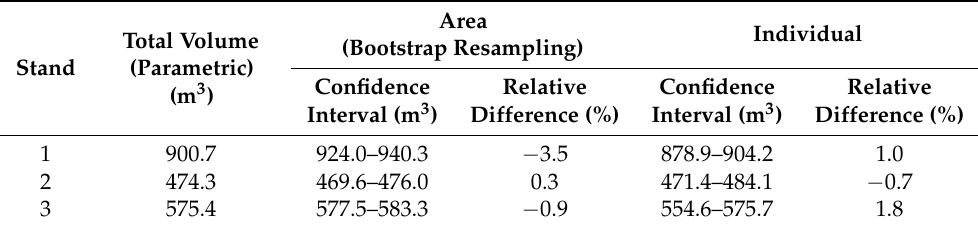
Table 5. Comparison of two approaches (area vs. individual) for predicting stand